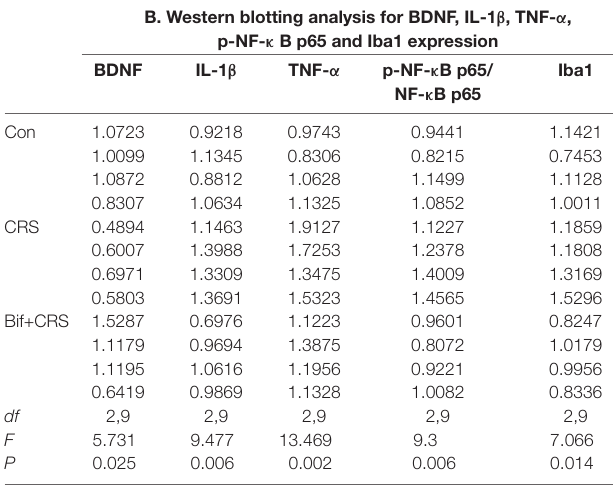
TABLE 5 | Changes in the protein expression of BDNF, IL-1 β , TNF- α , p-NF- κ B p65 and Iba1 in the hippocampus induced by pretreatment with B. adolescentis . B. Western blotting analysis for BDNF, IL-1 β , TNF- α , p-NF- κ B p65 and Iba1